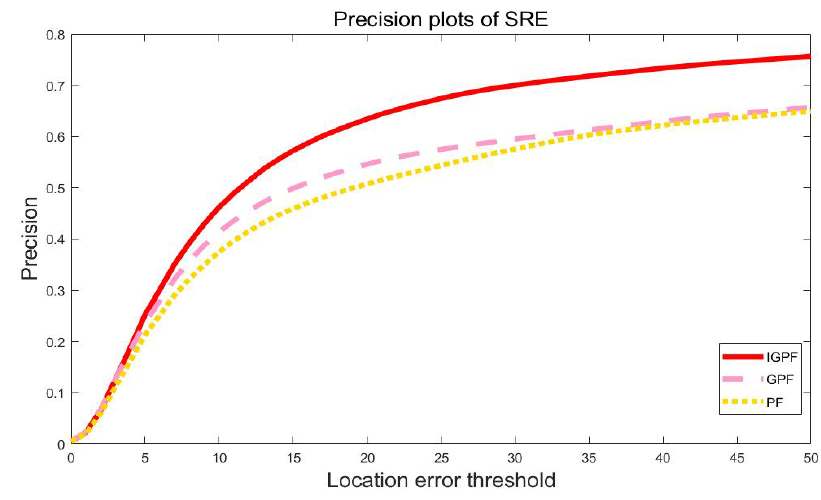
Figure 9. DP SRE curve.